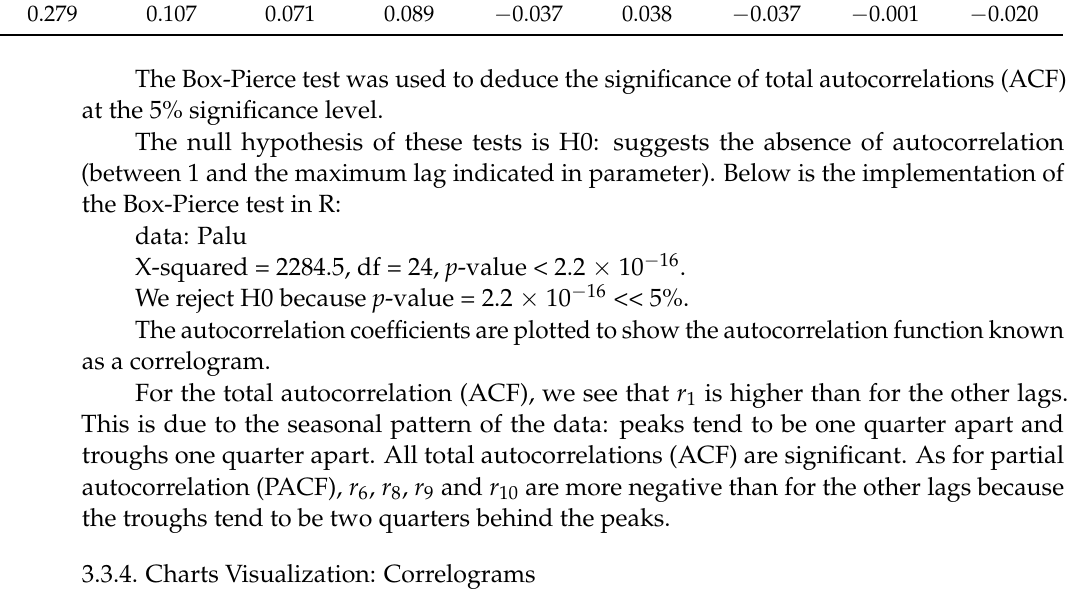
Table 1. Autocorrelation coefficients.